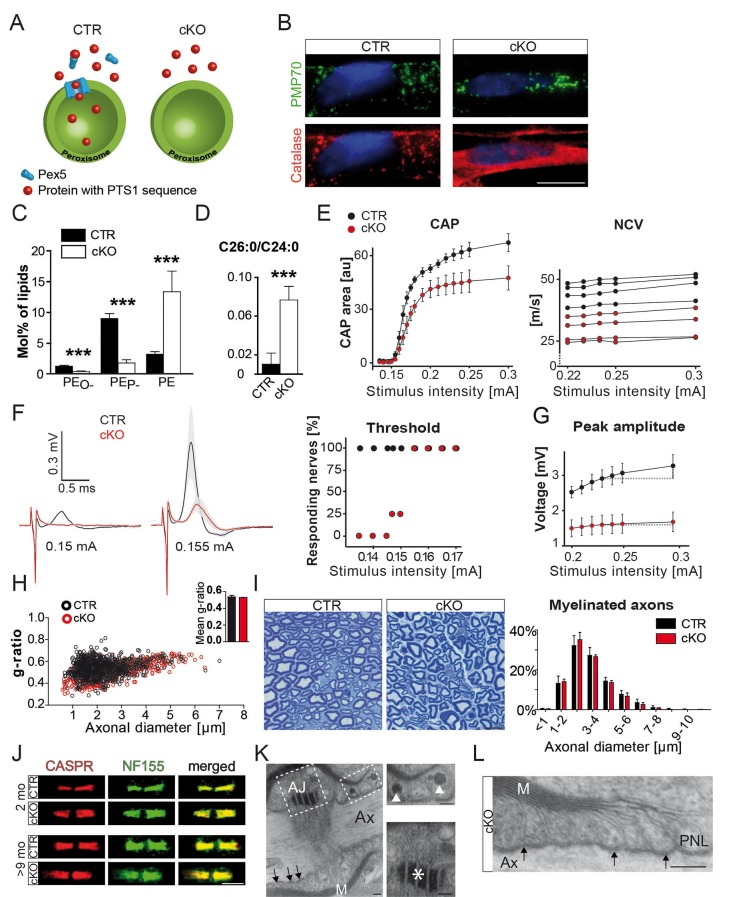
Schwann cell-specific PEX5-deficiency causes peroxisome dysfunction and peripheral neuropathy in the absence of axonal loss or dysmyelination.(A) Scheme of normal (left) and impaired (right) PEX5-dependent peroxisomal protein import. PTS1, peroxisomal targeting signal type 1; PEX5, peroxisomal biogenesis factor peroxin 5. (B) Catalase (red) is present in peroxisomes (PMP70; green) of controls, but is localized in the cytoplasm of mutant fibers. PMP70, peroxisomal membrane protein 70; DAPI-stained SC nuclei are depicted in blue; Scale bar, 10 µm. (C, D) Lipid mass spectrometry of nerve lysates from controls and mutants aged 9 months indicates peroxisomal dysfunction. Peroxisomal products (PEO-) and its corresponding plasmalogens (PEP-) are reduced. Specific substrates of peroxisomal β-oxidation, VLCFA, are accumulated in mutant nerves. Statistics: means ± s.d.; n = 6; Student’s T-test; ***p<0.001. (E–G) Functional impairment of mutant compared to control sciatic nerves is assessed by electrophysiology at the age of 2 months (n = 4). To evoke significant responses of all measured nerves, larger stimulus intensity is required for mutant (0.155mA) as compared to control (0.135mA) nerves. Peak amplitudes plotted against increasing stimulus intensity indicates earlier response saturation of mutant nerves. CAP, compound action potentials; au, arbitrary units; NCV, nerve conduction velocities (each curve representing single-nerve mean responses across intensities). (H) g-ratio analysis by electron microscopy of sciatic nerves as measure of myelin thickness (n = 3; ≥100 randomly chosen axons per nerve at age 2 months). (I) Axonal analysis by methylene blue-stained semithin cross-sections of sciatic nerves of control and mutant mice at the age of 2 months (n = 3). Scale bar, 10 µm. (J) Immunostained teased sciatic nerve fibers of mutants and controls at 2 and 9 months show normal paranodal localization of CASPR (red) and anchoring protein neurofascin (NF155; green). (K, L) Intact transverse bands (arrows) at paranodal loops (PNLs) between axon (Ax) and myelin (M) by electron microscopy in a 9-month mutant nerve, even when PNLs harbor enlarged vesicles (top inset, arrowheads). Mutant nerves display normal adherens junctions (AJ) between loops (bottom inset, asterisk). Scale bars, 500 nm; scale bars in insets, 250 nm.